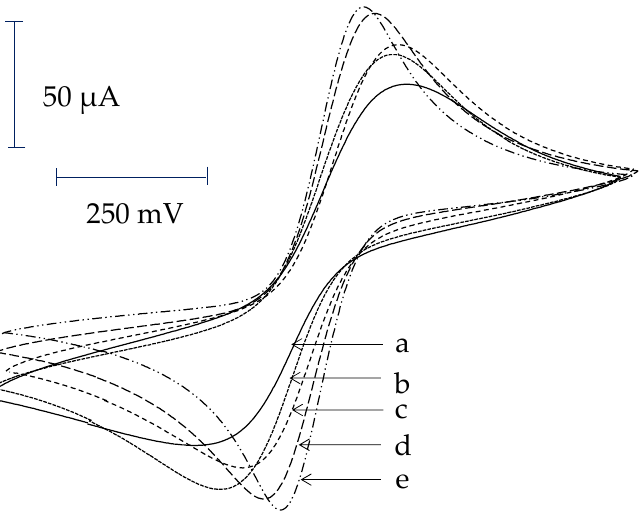
Figure 3. Cyclic voltammograms of electrodes modified with different number of layers ( a ) bare gold electrode, ( b ) LbL 1 , ( c ) LbL 2 , ( d ) LbL 3 , and ( e ) LbL 4 .